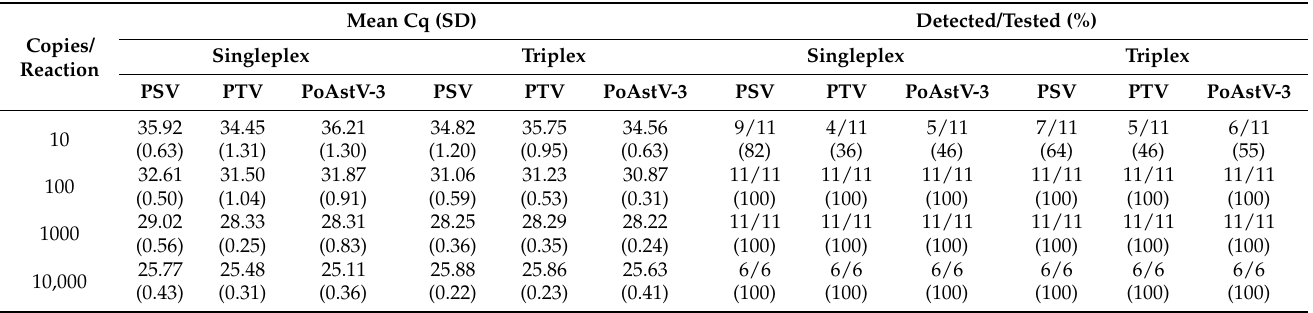
Table 2. Summary of the results of lower limit of detection analyses. Cq: quantification cycle, SD: standard deviation, PSV: porcine sapelovirus, PTV: porcine teschovirus, PoAstV-3: porcine astrovirus type 3.